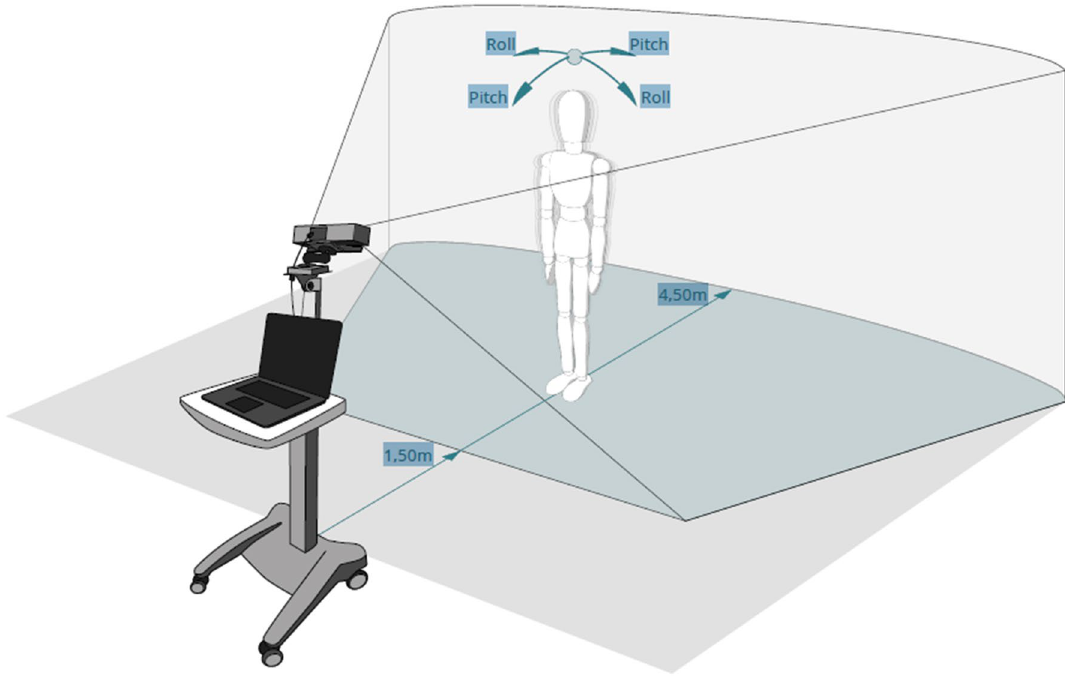
Figure 1. Set-up of quantitative motor assessment by visual-perceptive computing. Rol = anteriorposterior direction, Pitch = mediolateral direction.